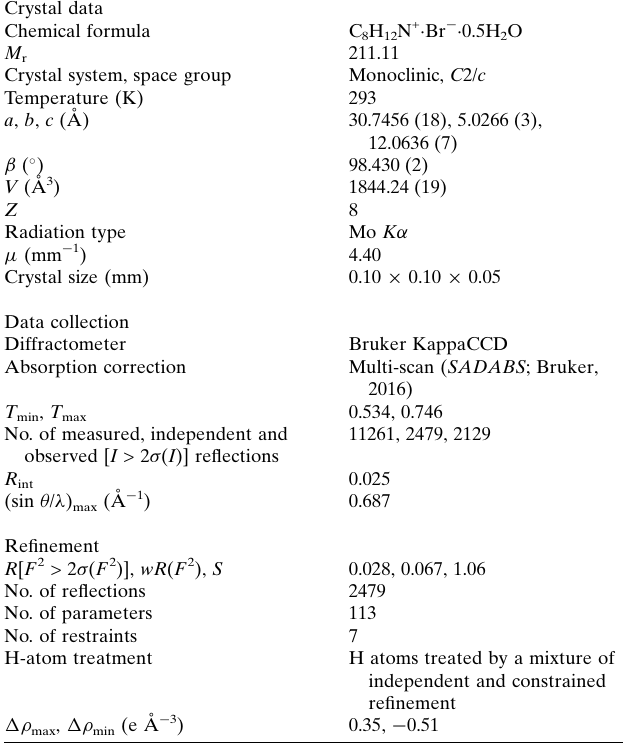
Table 2 Experimental details.